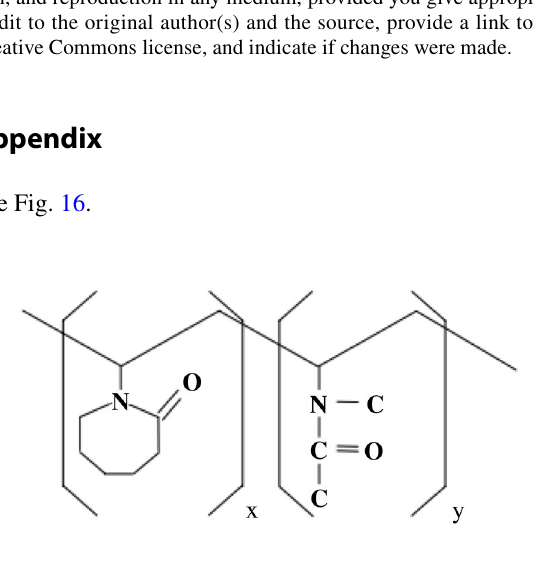
Fig. 16 The poly